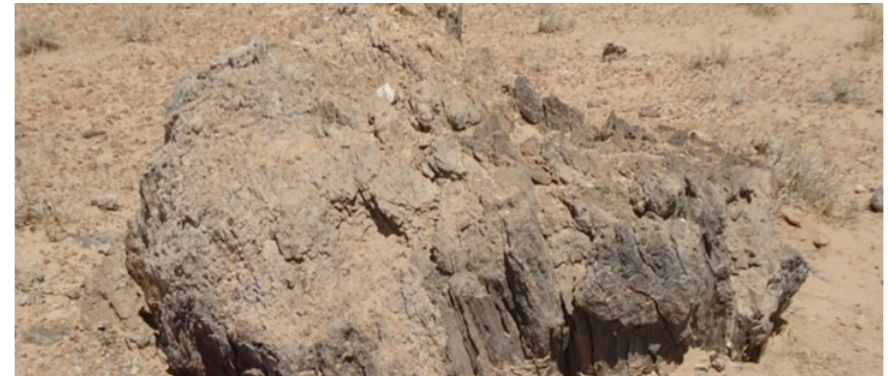
Fig. 8. View of petrified wood with a diameter of 1.75 m from the bottom of the lower sediment package (Scale for wood: